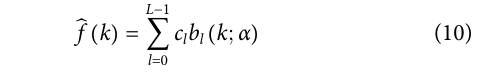
Frontiers in Physics |